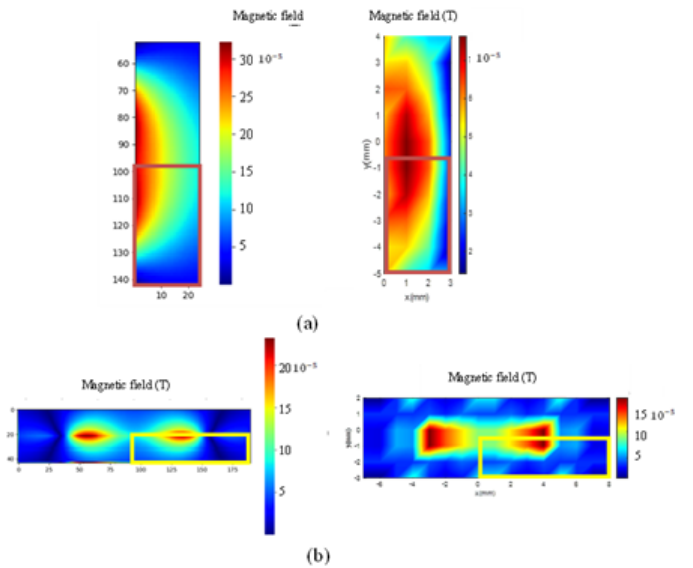
Figure 12. Comparison of simulation and test: ( a ) On the yellow surface measurement with symmet-